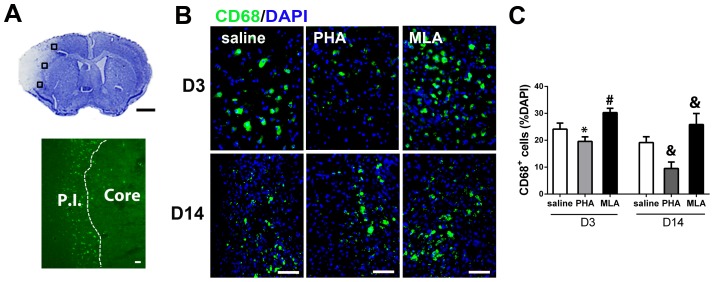
PHA decreased CD68+ cells in the peri-infarct region.A: An image of cresyl violet-stained coronal section shows the areas used for cell-quantification (top, squared regions, scale bar: 1 mm) and an image of CD68 antibody-stained section shows the infarct border (bottom, white dotted line, scale bar: 50 um). P.I.: peri-infarct region. B: Representative images show the CD68+ cells in the peri-infarct region. The nuclei were counterstained with 4',6-diamidino-2-phenylindole (DAPI). C: Bar graph shows the percentage of CD68+ cells among total cells (DAPI positive nuclei) in the peri-infarct region. *: p = 0.001, #: p<0.001 vs. saline group 3 days after pMCAO; &: p<0.001 vs. saline group 14 days after pMCAO.